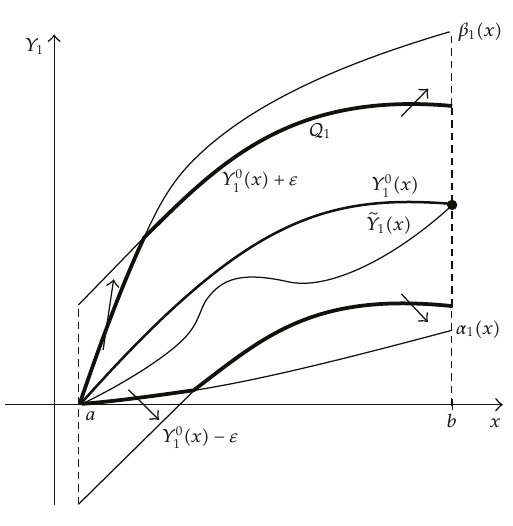
Figure 3: Continuity of T (cid:3) the first case (cid:4) .